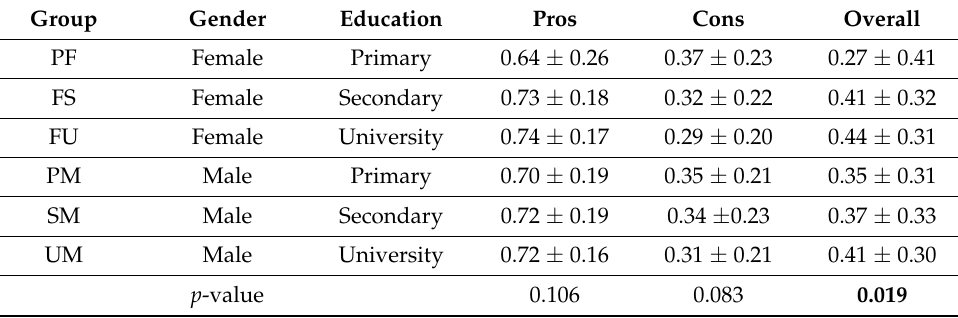
Table 14. Mean and standard deviation of preparedness scores by gender and education and p -values from the Kruskal-Wallis test ( α = 0.05). Pros [0, 1] = in favor of preparedness; Cons [0, 1] =